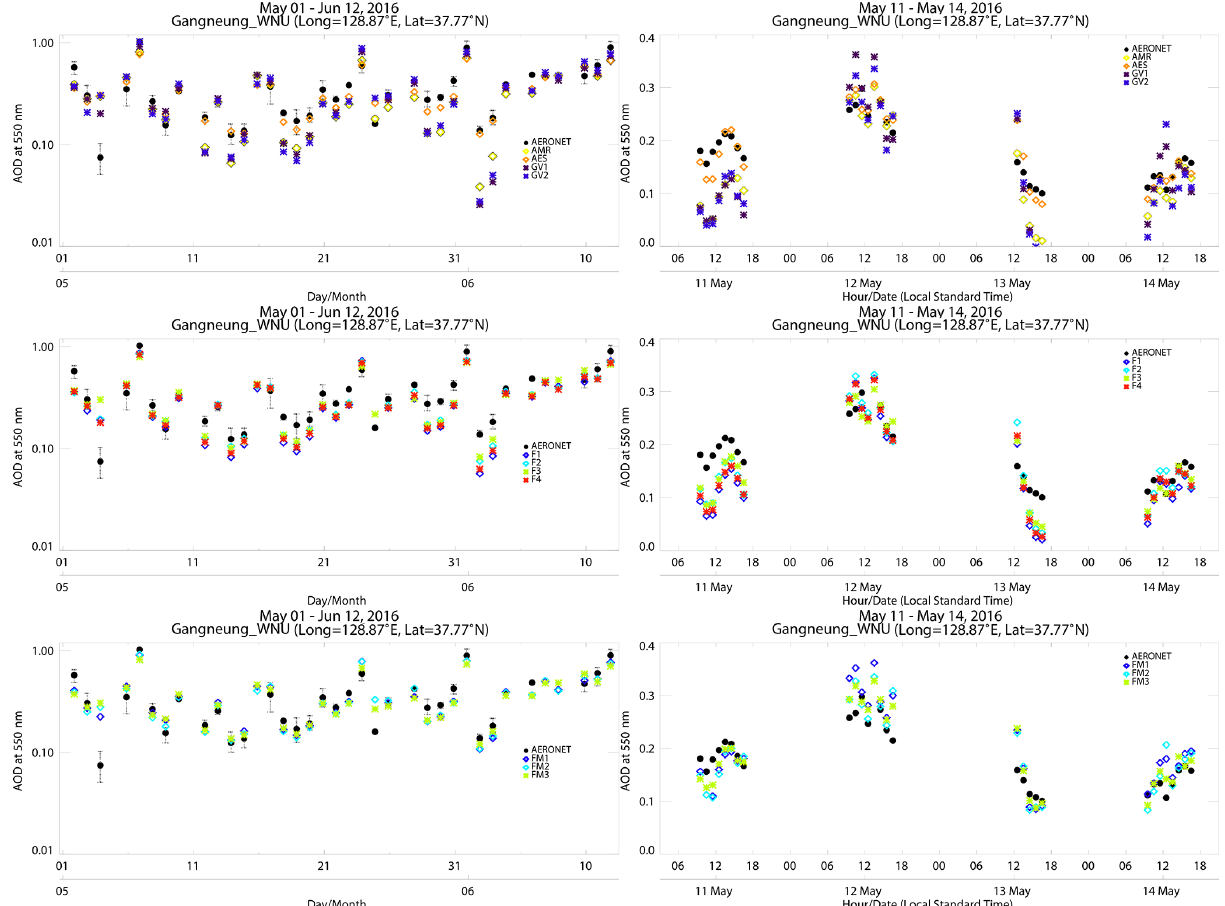
Figure 9. Time series of the daily average AODs at the Gangneung-WNU site during the KORUS-AQ campaign from the (a) respective satellite, (c) ensemble mean, and (e) MLE fusion. The black-filled circles represent AERONET AOD, and the error bars represent 1SD of daily AERONET AODs. The diurnal variation in AODs from 11 to 14 May 2016 is shown in panels (b) , (d) , (f) , where panel (b) is the respective satellite, panel (d) is fused, and panel (f) is MLE